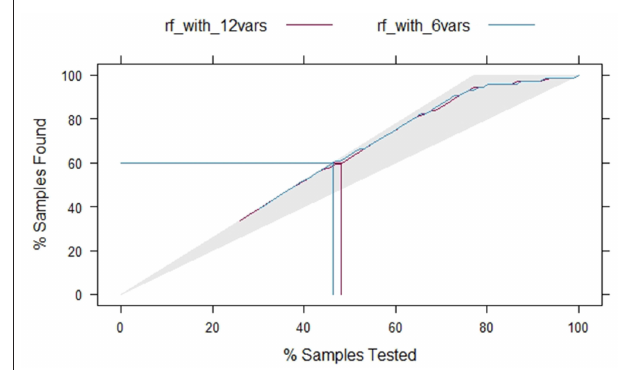
FIGURE 5 | Lifting curves of the two